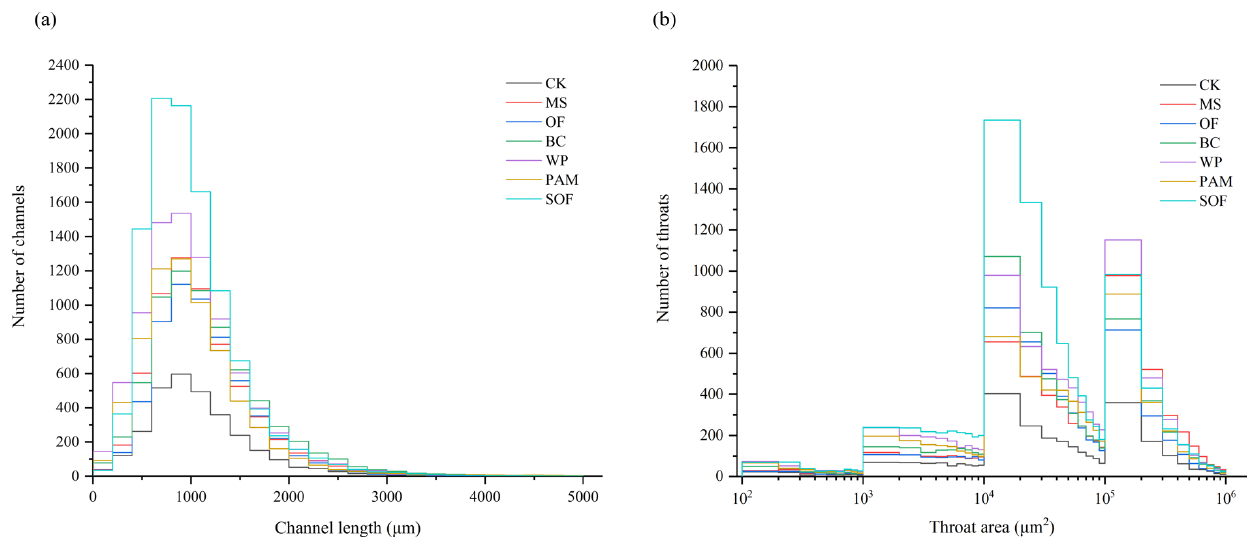
Figure 6. Distribution of channel length and pore throat area in the organic-treated soil cores. ( a ) channel length and ( b ) pore throat area. ( a ) channel length and ( b ) pore throat